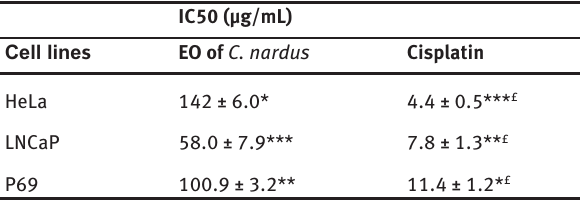
Table 3: IC50 (µg/mL) of essential oil of C. nardus tested on LNCaP human prostate cancer cell lines, HeLa human cervical cancer cell lines and P69 non-cancerous human prostate epithelial cell lines.